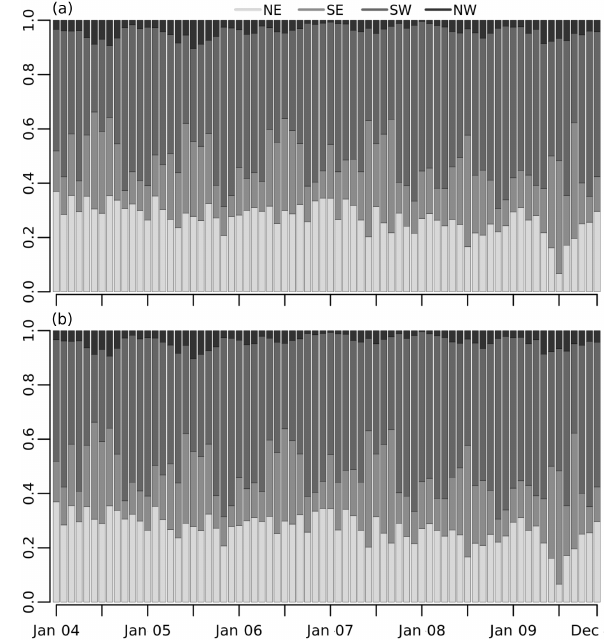
Figure 4. Monthly wind sector relative frequency (%) for meteoro- logical stations (a) ECSF and (b) Cerro del